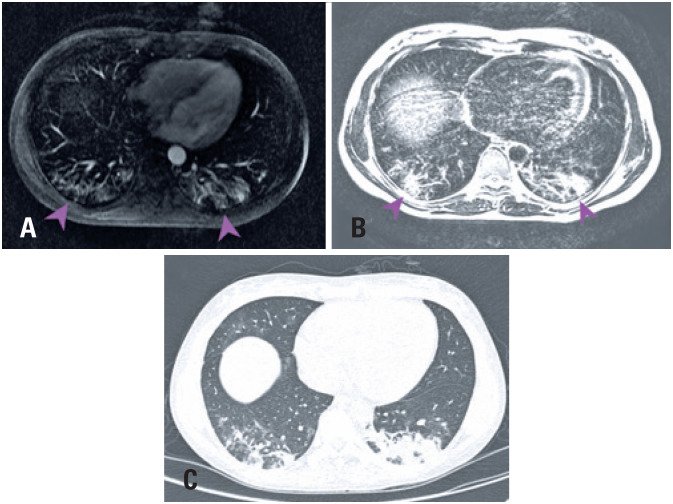
(A) corte axial da ressonância magnética de abdome superior em sequência T2 evidencia opacidades bilaterais nas bases pulmonares, com predomínio posterior e subpleural, suspeitas para acometimento por COVID-19; (B) alteração de janela da mesma imagem ponderada em T2 de ressonância, tornando os achados mais conspícuos e evidentes, similares ao esperado em uma tomografia computadorizada; (C) imagens da tomografia computadorizada do tórax da paciente no mesmo nível, demonstrando a grande semelhança das alterações caracterizadas nos cortes de ressonância magnética